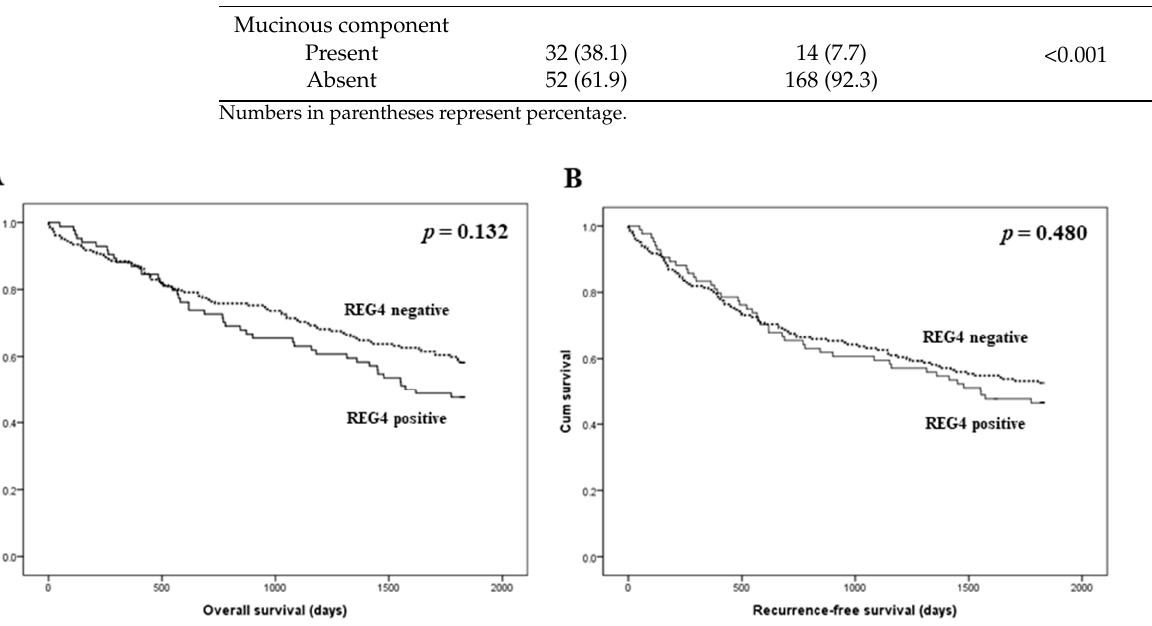
Figure 2. Kaplan-Meier analysis of patient survival according to REG4 expression in overall cases. ( A ) Overall survival. ( B ) Recurrence-free survival.